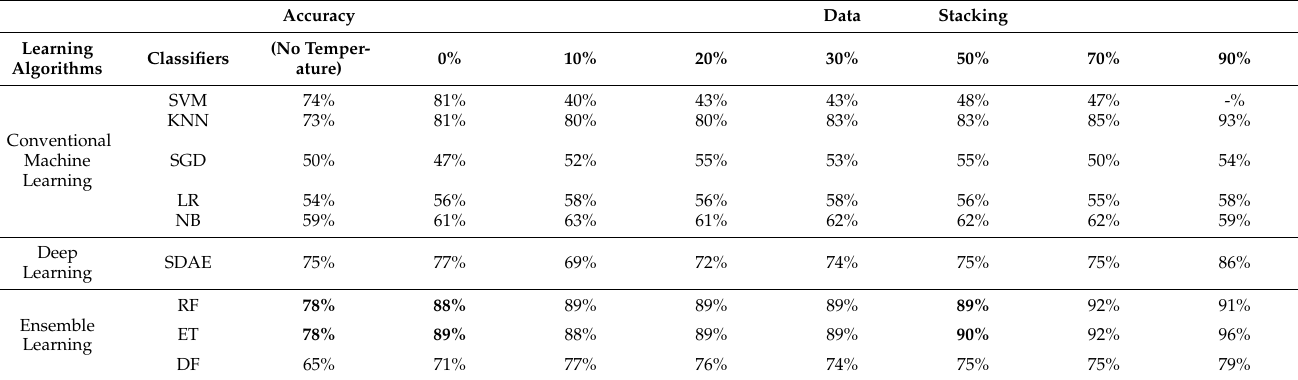
Table 3. Accuracy of activity recognition